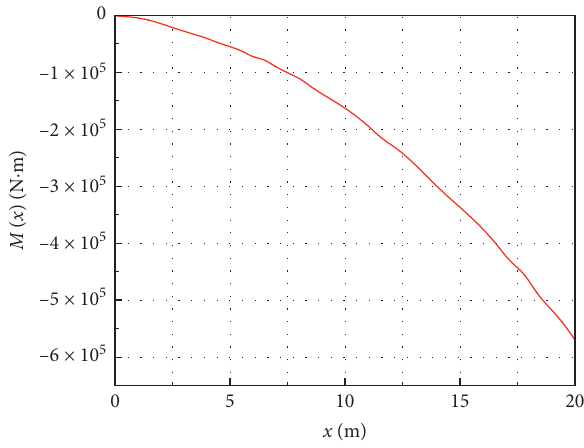
Figure 10: The variation of bending moment (III).